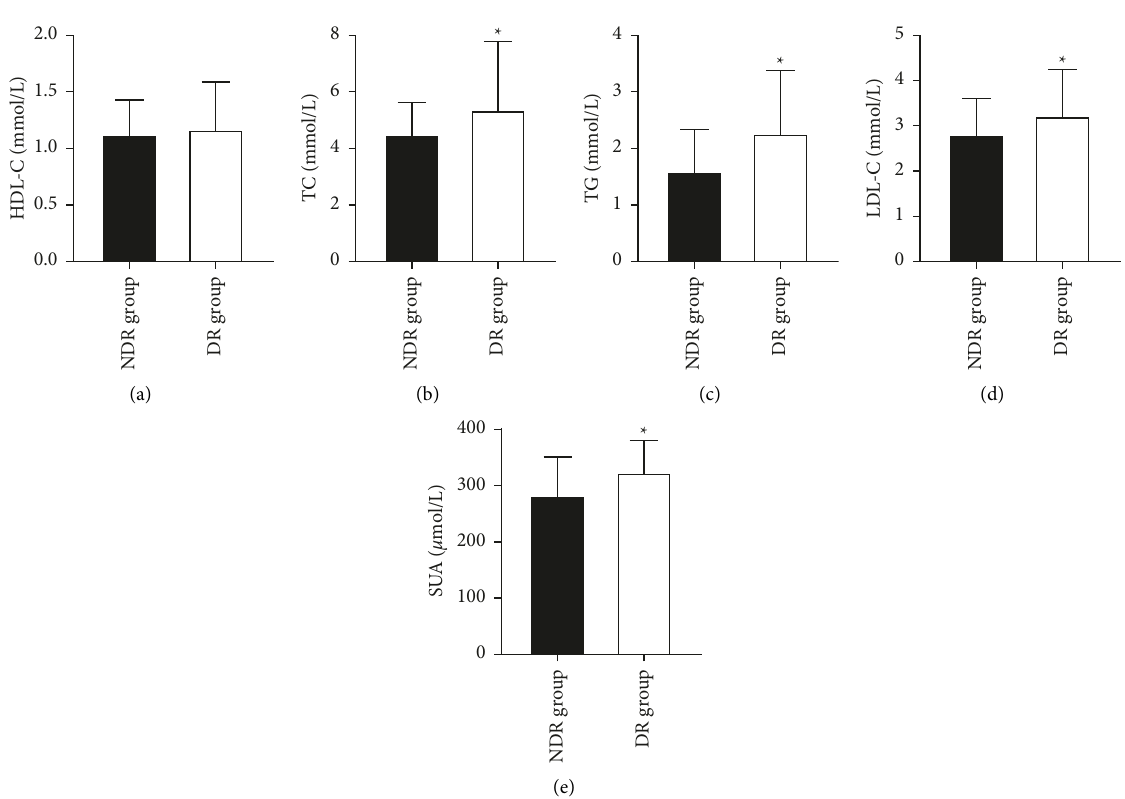
Figure 2: Comparison of lipid metabolism levels and blood uric acid levels between the two groups ( n x (mmol/L), TG (mmol/L), LDL-C (mmol/L), and SUA ( μ mol/L), respectively; groups ( P 0 . 05). < Table 2: Multifactor assignment method. Influencing factors